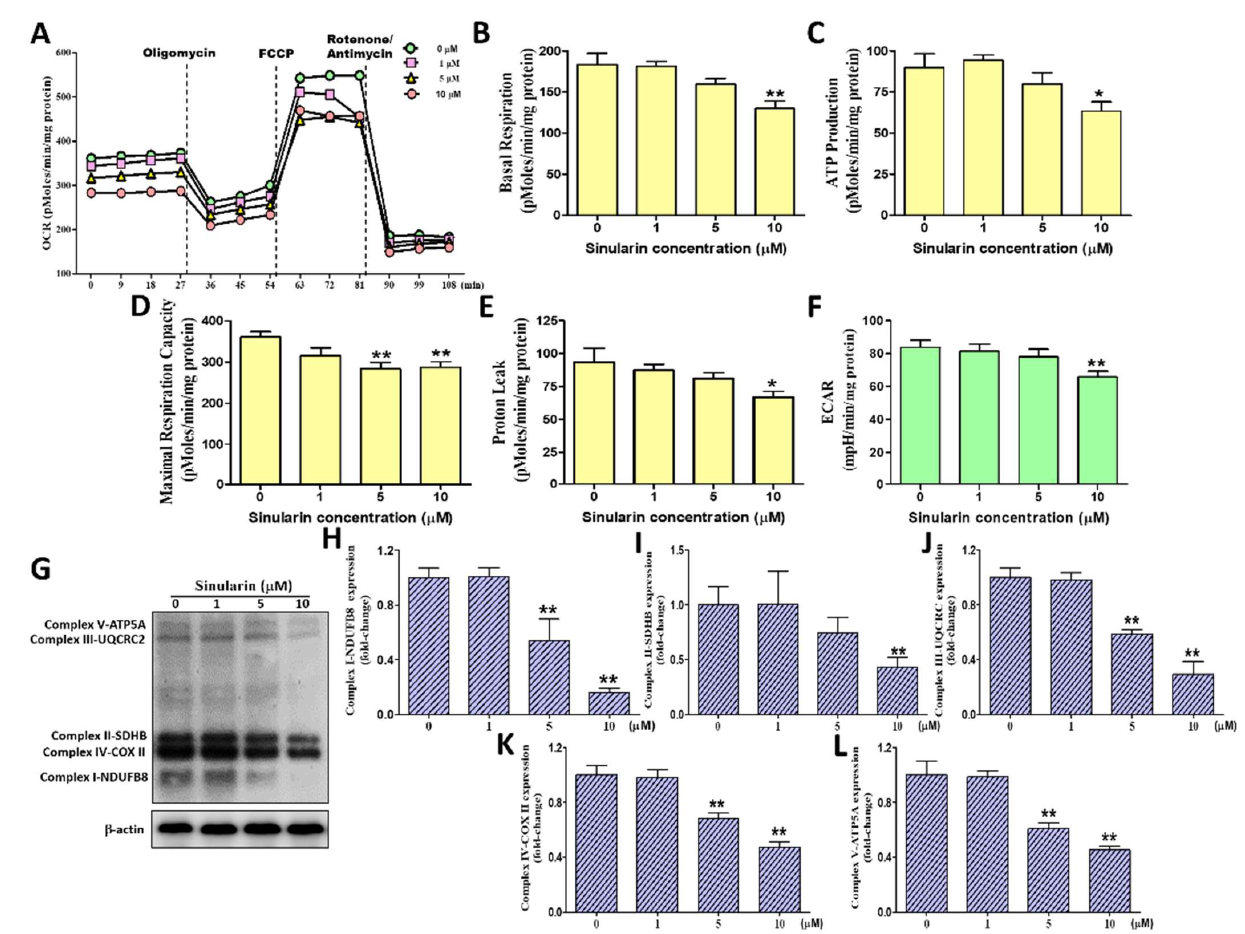
Figure 3. The effects of sinularin on the OCRs (Oxygen consumption rates) parameter, ECARs (extracellular acidification rate), and 5 OXPHOS (Oxidative phosphorylation) enzymatic complexes in SK-HEP-1 cells. The OCRs (pMoles/min/mg protein) were measured before and after the addition of pharmacological agents to living cells. The ECARs (mpH/min/mg protein) were measured before the addition of pharmacological agents to living cells. Four measurements were taken and averaged to provide reliable data as a base value, followed by sequential and continuous injections of Seahorse XF Cell Mito Stress Test reagents, including oligomycin, FCCP, and antimycin/rotenone. ( A ) A graph of OCR values versus time-course (min). ( B ) Quantification of basal respiration OCRs. ( C ) Quantification of couple respiration OCRs (ATP production) ( D ) Quantification of maximal respiration capacity OCRs. ( E ) Quantification of proton leak respiration OCRs. ( F ) Quantification of ECARs. ( G ) The Western blot profile showed the effects of sinularin on the expression levels of complex I-NDUFB8, complex II-SDHB, complex III-UQCRC2, complex IV-COX II, and complex V-ATP5A. β -actin was used as the internal control. Full, uncropped Western blot gels are shown in Supplementary Figure S2D. The complex I-NDUFB8 ( H ), complex II-SDHB ( I ), complex III-UQCRC2 ( J ), complex IV-COX II ( K ), and complex V-ATP5A ( L ) protein levels were quantified by densitometry analysis using ImageJ software after being normalized with the β -actin level. Each bar represents the mean ± SE of three independent experiments. The results were analyzed using Student’s t -test to determine the significance, in which * p < 0.05 and ** p < 0.01 relative to the control (sinularin-untreated